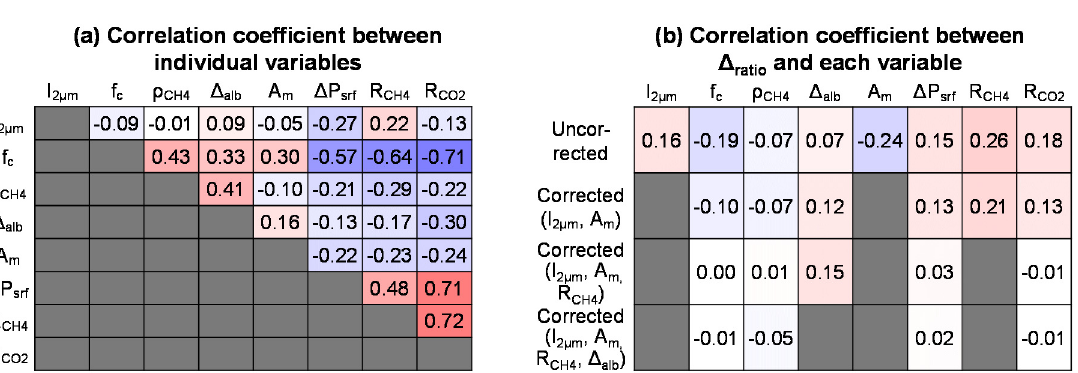
Figure 6. Correlation coe ffi cient ( a ) between variables and ( b ) between the relative di ff erence in the ratio component between GOSAT and TCCON ( ∆ ratio ) and variables. The color in the figure corresponds to the coe ffi cient value (blue: large negative coe ffi cient; white: zero; red: large positive coe ffi cient). The meaningless pixels are filled by gray. Eight variables were used: the normalized 2 µ m band radiance (I 2 µ m ), cloud fraction (f c ), retrieved surface albedo of CH 4 band ( ρ CH4 ), di ff erence in the retrieved surface albedo (CH 4 band minus CO 2 band, ∆ alb ), airmass (A m ), deviation of the retrieved clear-sky surface pressure from its prior ( ∆ P srf ), and ratio between the partial column-averaged dry-air mole fractions for the lower atmosphere and that for the upper atmosphere (R CH4 and R CO2 ). In ( b ), results for bias-uncorrected ∆ ratio and bias-corrected ∆ ratio (corrections using two, three, and four variables) are shown. Data with f c = 0 and that with I 2 µ m ≤ 1 were used. Only data with NDSI ≤ 0.4 were used to calculate the correlation coe ffi cient for f c .